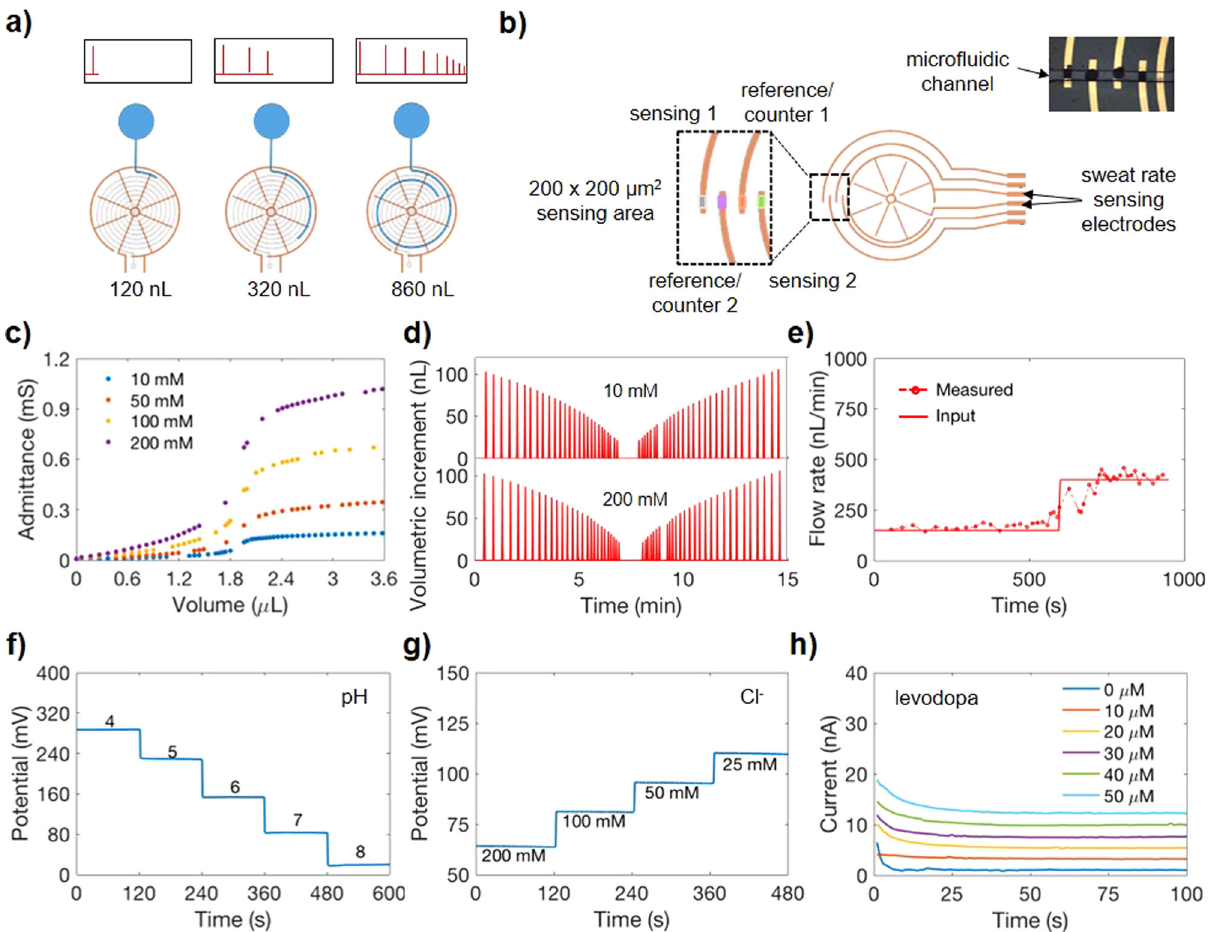
Fig. 3 Sweat sensor characterization. a An impedimetric sweat rate sensing electrodes for detection of secretion rate is illustrated. An admittance (reciprocal of impedance) pulse is measured upon fl uid contacting each of the radial electrode. b Electrochemical sensors for compositional analysis are functionalized near the tip of the four semicircles. These sensors are embedded inside the microchannel. c Admittance responses to solution containing NaCl concentrations of 10, 50, 100, and 200 mM. d Incremental volume fi lled inside the microchannel with respect to time is plotted when 10 and 200 mM NaCl solutions are fl owed at a constant rate of 250 nL/min. The incremental volume corresponds to additional fl uid fi lled between two adjacent radial electrodes. e Input fl ow rate from syringe pump and measured fl ow rate from sweat rate sensor are compared. Performance of ( f ) pH, ( g ) Cl − , and ( h ) levodopa sensors are